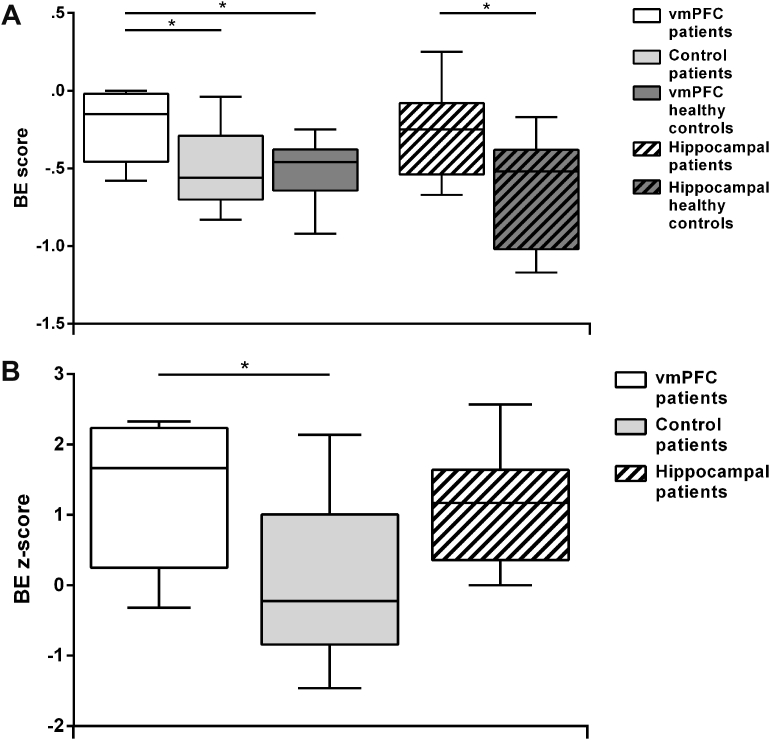
A: Box-plots of boundary extension (BE) scores by participant group. The data and significance levels contrasting patients with hippocampal damage and their controls are from Mullally et al. (2012). The more negative the score, the more BE. B: Box-plots of BE z-scores for the three patient groups. Boxplots depict the median, first and third quartiles, and minimum and maximum (whiskers) of the data sets. *p < .05.